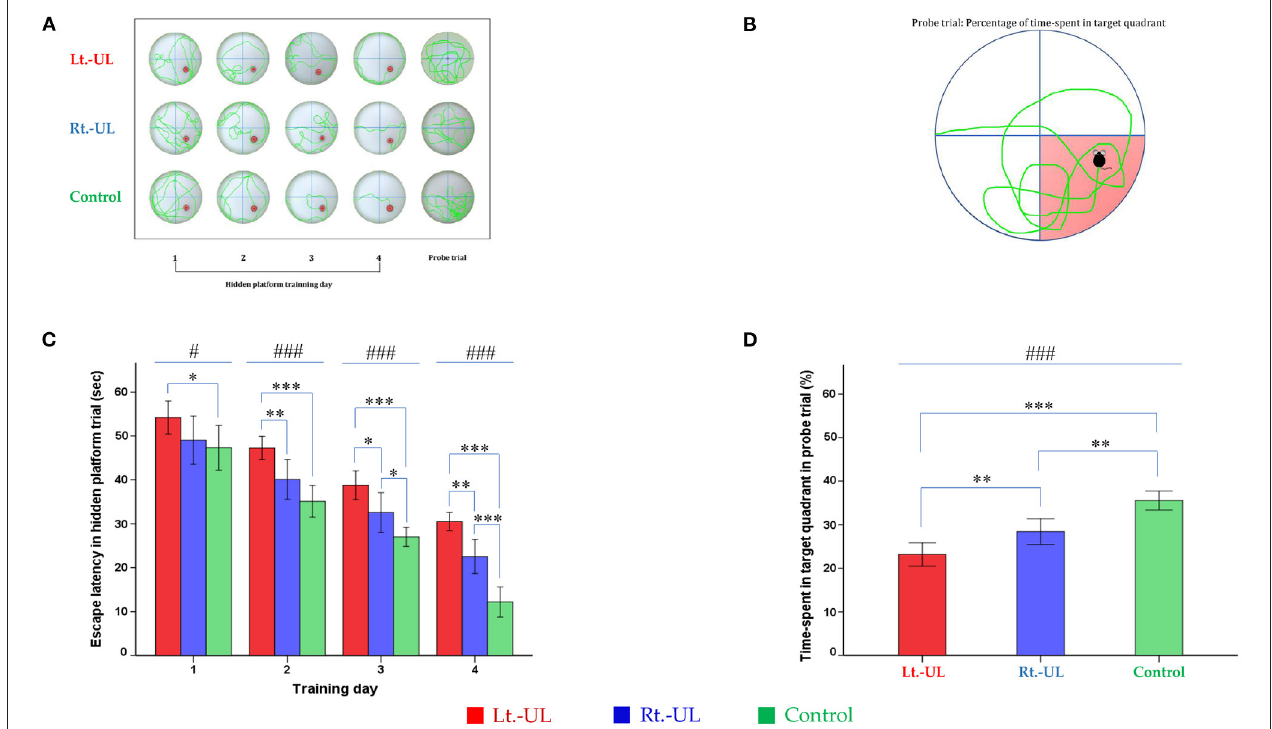
FIGURE 4 | Evaluation of long-term spatial reference memory with the Morris water maze (MWM). The process of hidden platform training (POD 10–13) (A) and the probe trial on POD 14 (B) . Compared with the control group, the Lt.-UL mice showed longer escape latency from TD 1, 2, 3 to 4. The Rt.-UL mice showed reduced values compared with the control mice on the two last TDs. Subgroup analysis revealed that the Lt.-UL mice showed markedly longer escape latency than the Rt.-UL group in the last 3 days (C) . During the probe trial on POD 14, there was a decreased percentage of time spent in the target quadrant in both Lt.-UL and Rt.-UL groups compared with the control group. The Lt.-UL mice showed a lower percentage of time in the target quadrant values compared with the Rt.-UL mice (D) . The values are indicated as mean ± SD. Statistical significances were calculated using the one-way ANOVA with post-hoc tests. *Significantly different between two groups; #significantly different between three groups; *, # p < 0.05; ** p < 0.01; ***, ### p <